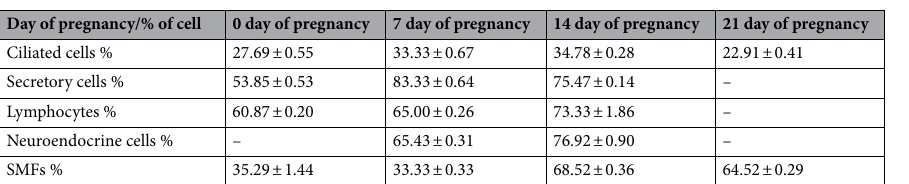
Table 1. Percentage of immunohistochemical positive cells for ERA (Means ± SEM)